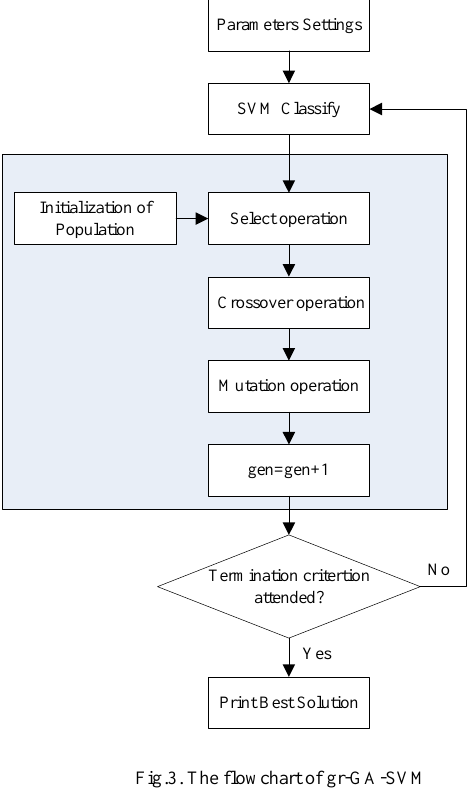
Fig.3. The flowchart of gr-GA-SVM